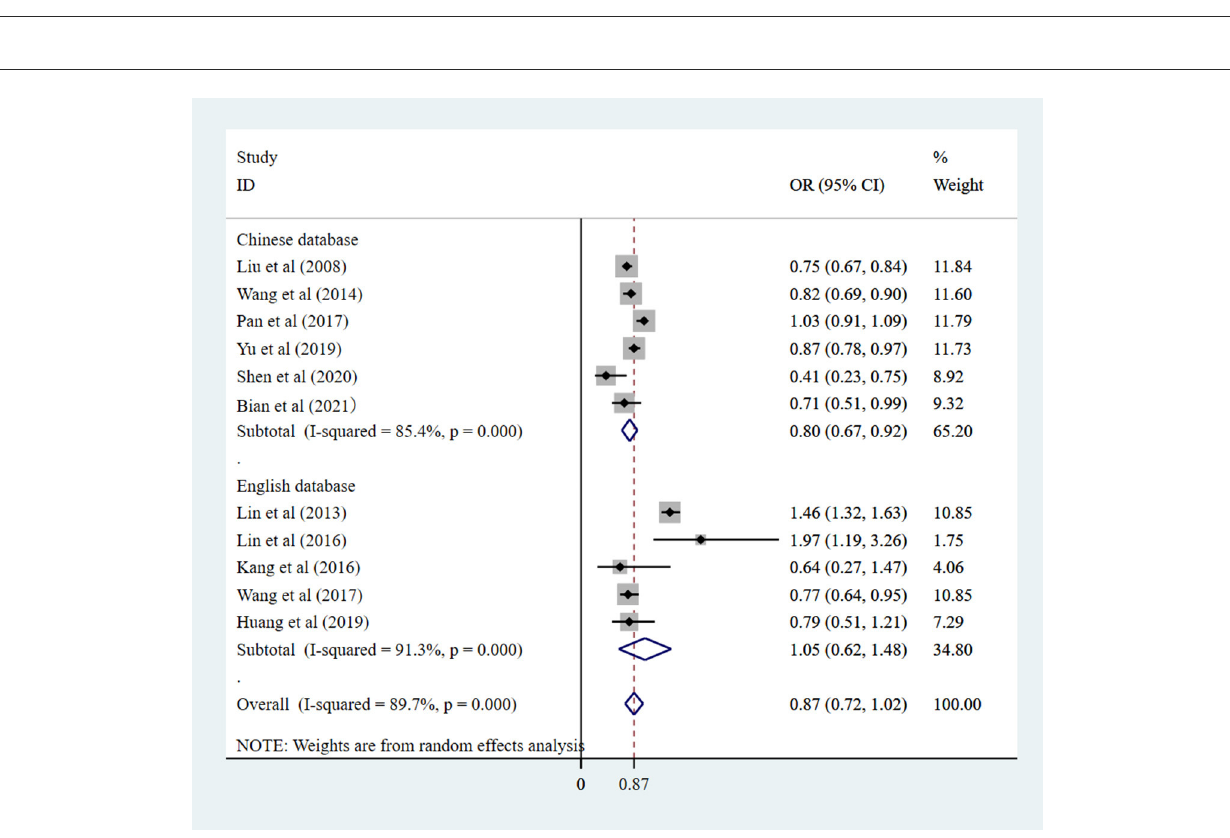
FIGURE3 Language database subgroup of the studies on the correlation between eye exercises and myopia in children and adolescents in multivariate analysis.